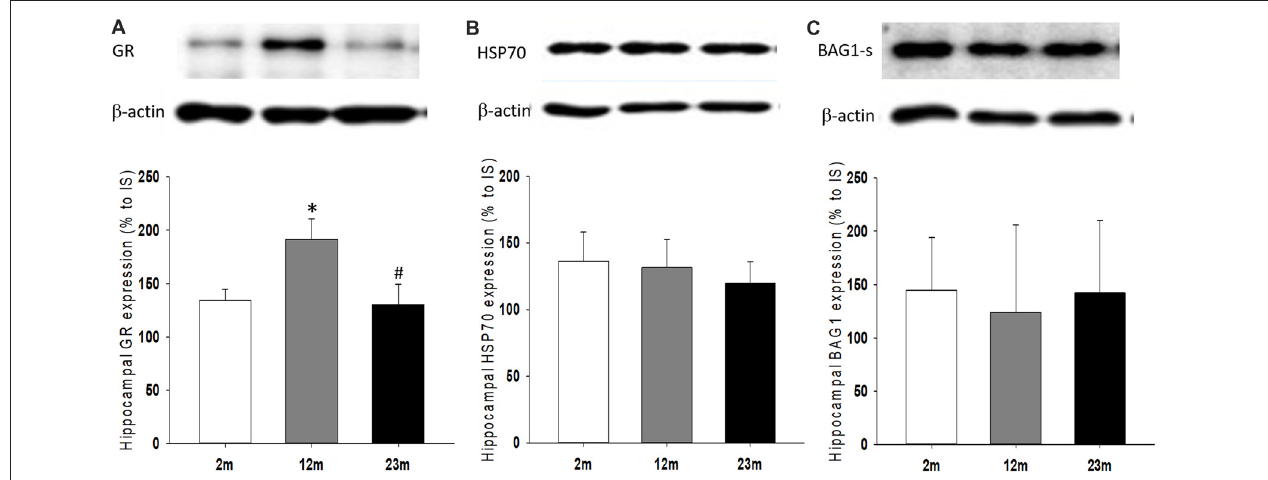
FIGURE 5 | Age differences in hippocampal expression of glucocorticoid receptor (GR) and regulatory co-chaperones. (A) Relative expression of GR. ANOVA showed a significant age group difference ( F ( 2,33 ) = 4.1, p = 0.025). By pairwise comparisons, GR expression increased in 12-month-old mice (2 month vs. 12 month, p = 0.039) and decreased in 23-month-old mice (12 month vs. 23 month, p = 0.04). (B) Relative expression of HSP70. (C) Relative expression of BAG-1s. All data are the mean ± SEM. 2 mo: 2-month old ( n = 17), 12 mo: 12-month old ( n = 11), 23 mo: 23-month old ( n = 11). % to IS, percent to internal standard. ∗ p < 0.05 vs. 2 mo, # p < 0.05 vs. 12 mo.